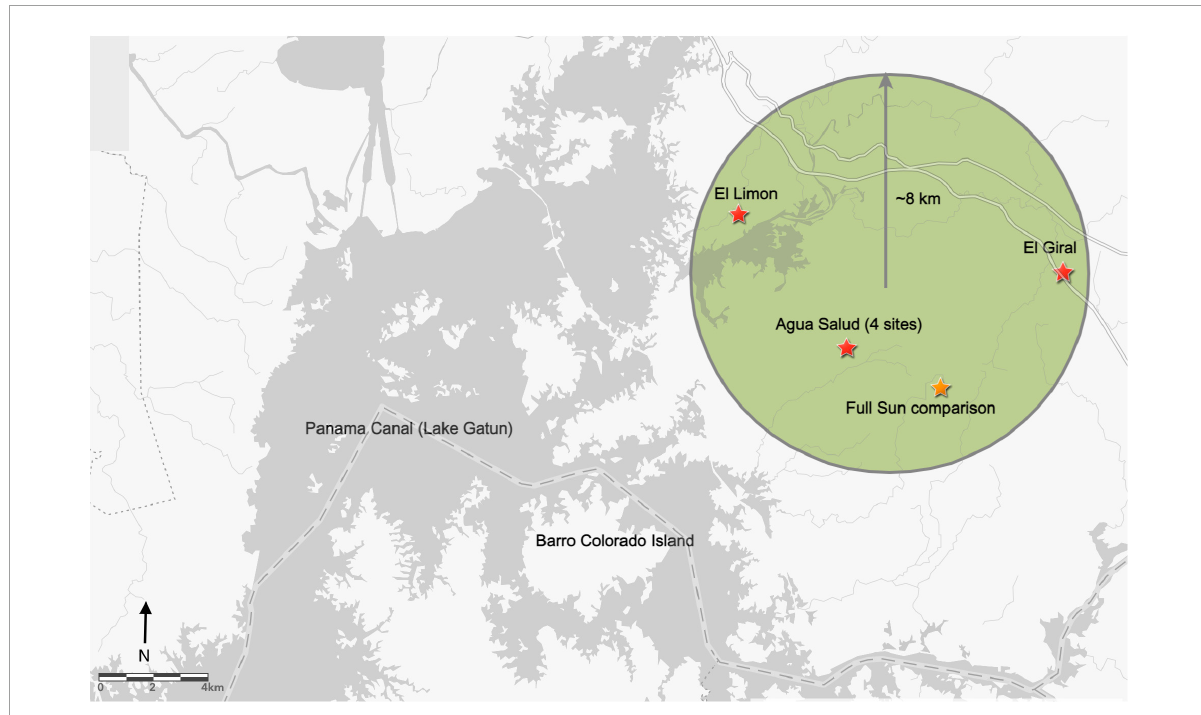
FIGURE1 Study area locations (stars) in the Eastern Panama Canal watershed, within an approximately 8 km radius (Longitude: 9 ◦ 11 (cid:48) 55 (cid:48)(cid:48) N to 9 ◦ 17 (cid:48) 02 (cid:48)(cid:48) N and Latitude: 79 ◦ 41 (cid:48) 01 (cid:48)(cid:48) W to 79 ◦ 47 (cid:48) 07 (cid:48)(cid:48) W). Two planting areas are in privately owned teak plantations near the towns of El Limon and El Giral. The remaining four areas are located within the 30-ha teak plantation in the Agua Salud research